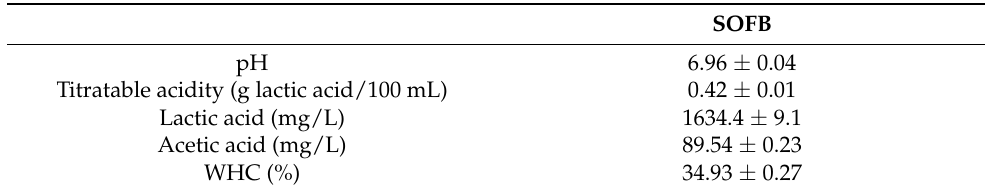
Table 1. Physico-chemical characteristics of Sprouted Oat Fermented Beverage